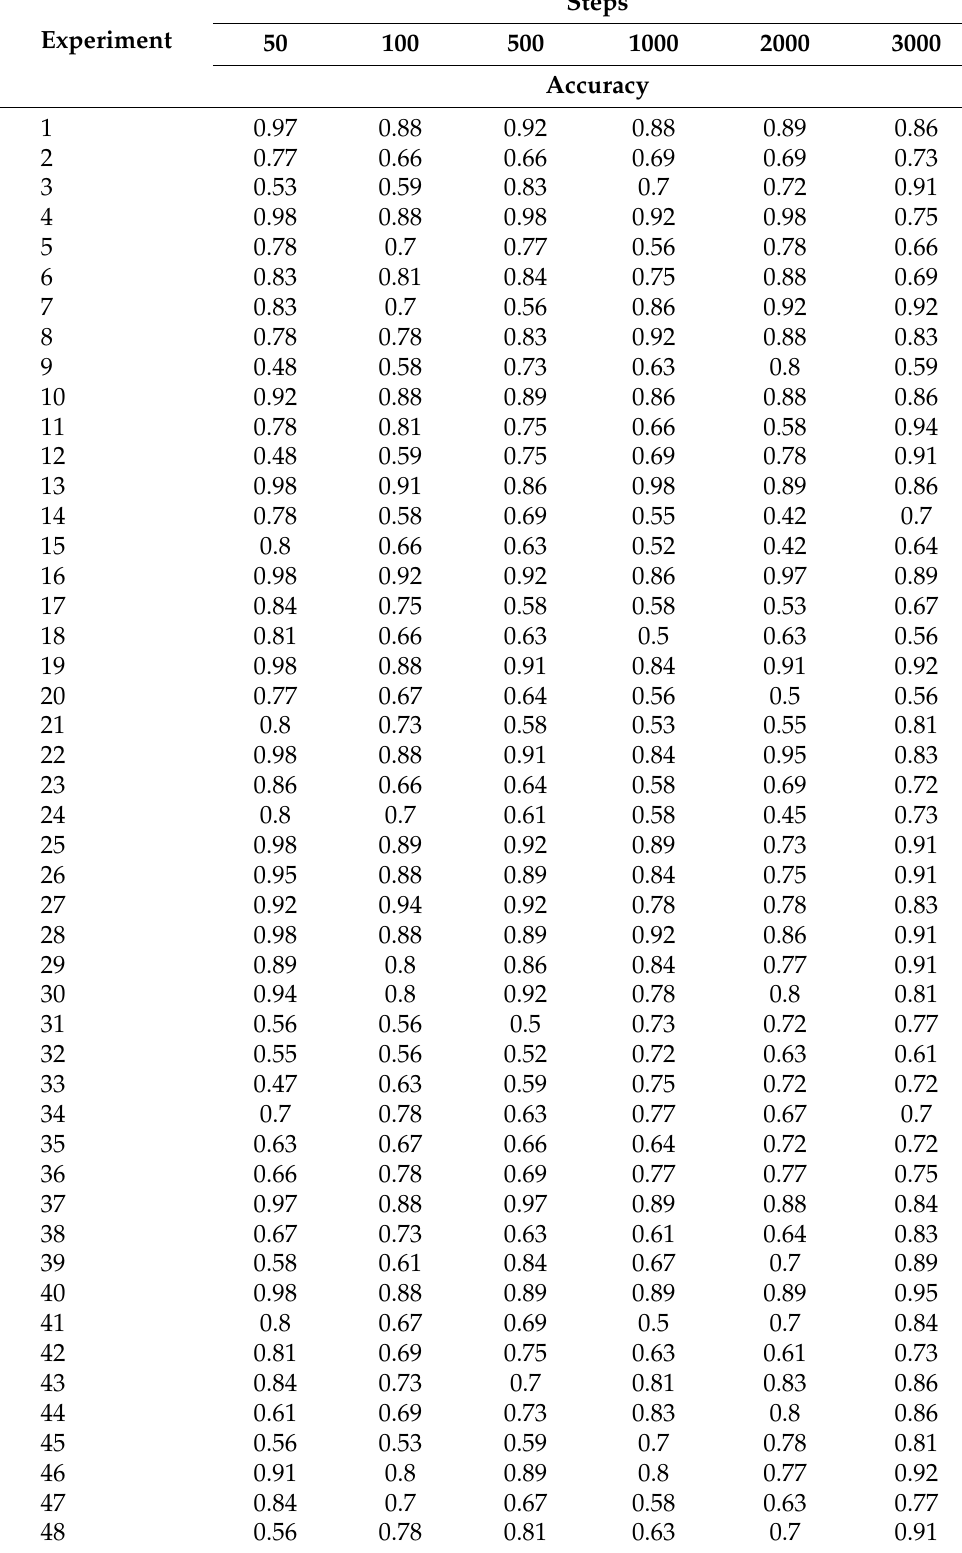
Table 5. Accuracy performance under the revenue